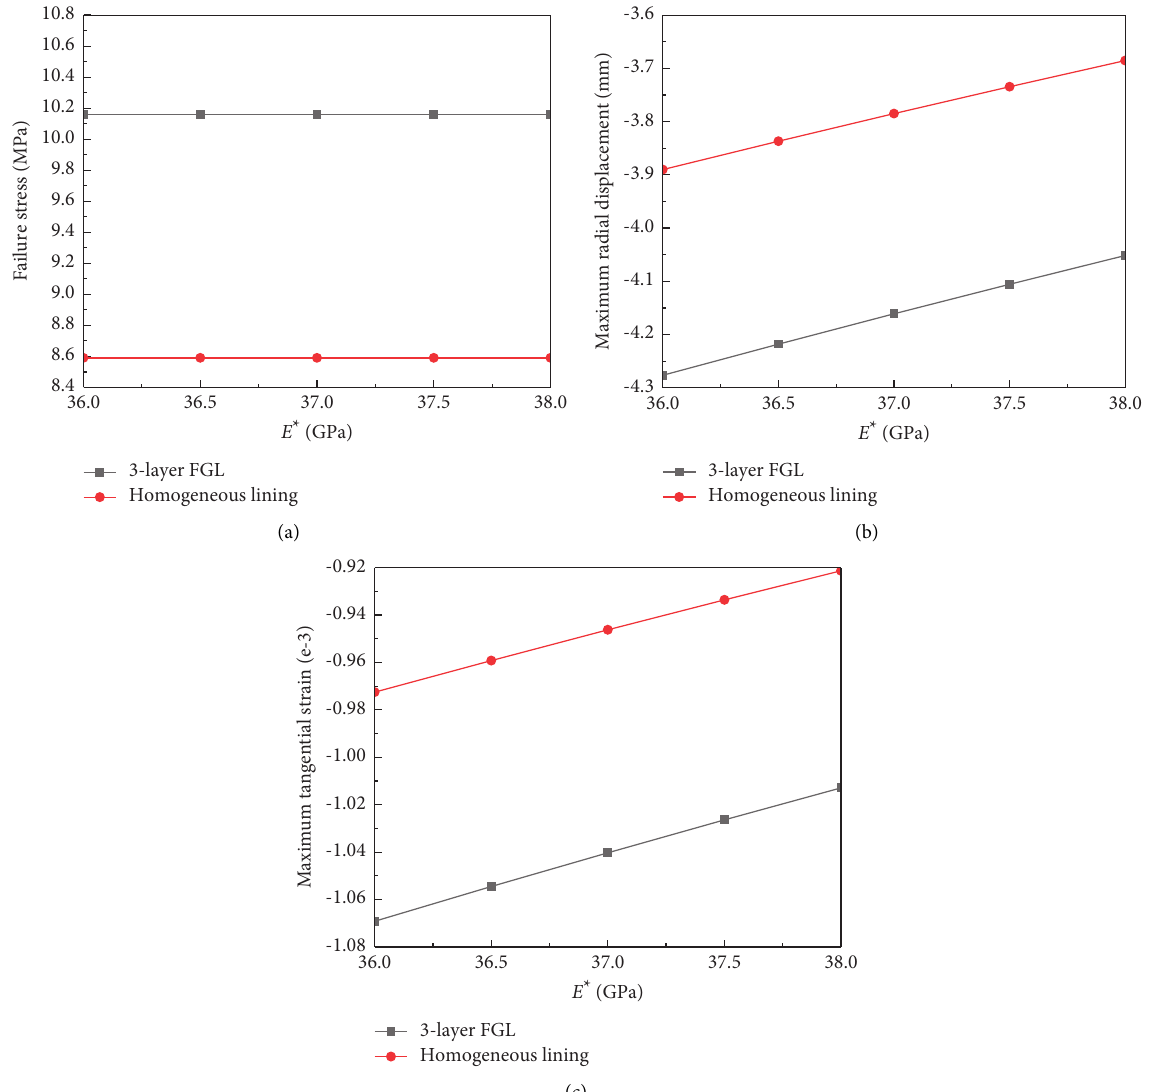
Figure 12: Variations in ultimate bearing capacity, maximum radial displacement, and maximum tangential strain with Young’s modulus E ∗ . (a) Ultimate bearing capacity. (b) Maximum radial displacement. (c) Maximum tangential